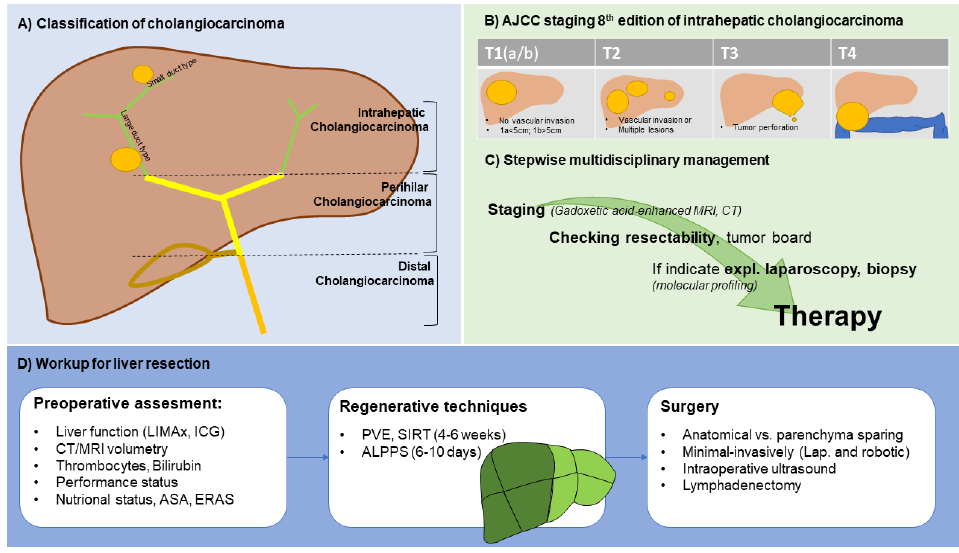
Figure 1. Schematic presentation of staging and management of intrahepatic cholangiocarcinoma.